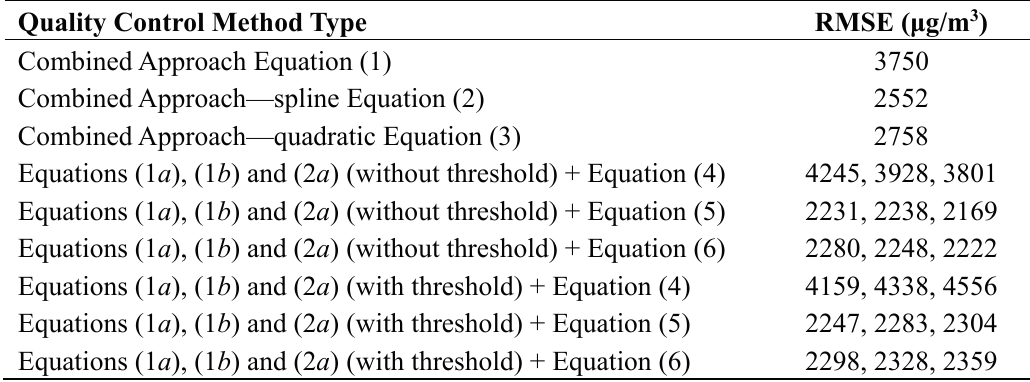
Table A2. Updates of RMSEs on different overall pDR-1000 adjustment approaches (updated version of original Table 3 from Soneja et al. , 2014